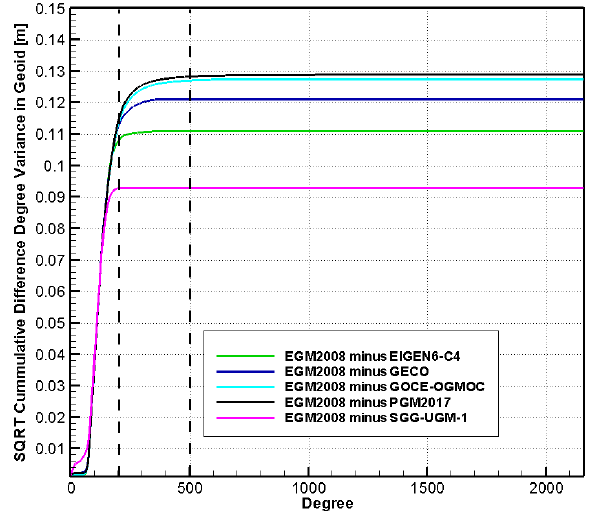
Fig. 2. Geoid height differences between EGM2008 and high resolu- tion models under investigation as square root of cumulative signal degree variance differences in terms of geoid heights (dashed lines mark the degrees 200 and